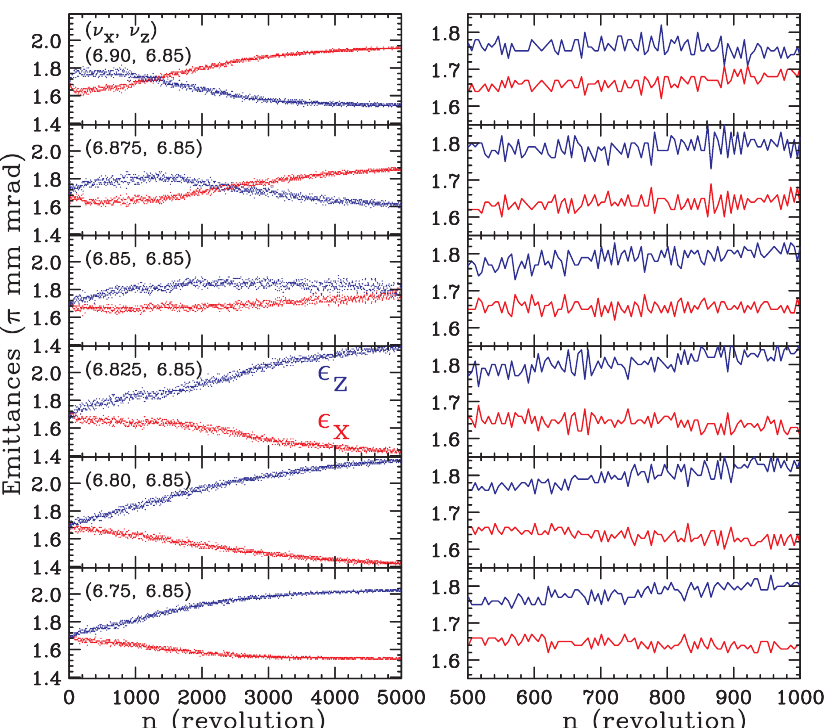
FIG. 31. (Color) The emittance evolution for a beam with 12-turn injection when only the space-charge force is included in the calculation. The horizontal betatron tune is varied across the vertical betatron tune to examine the effect of Montague resonance. The right plots zoom in on revolution 500 to 1000 to see the details of the emittance